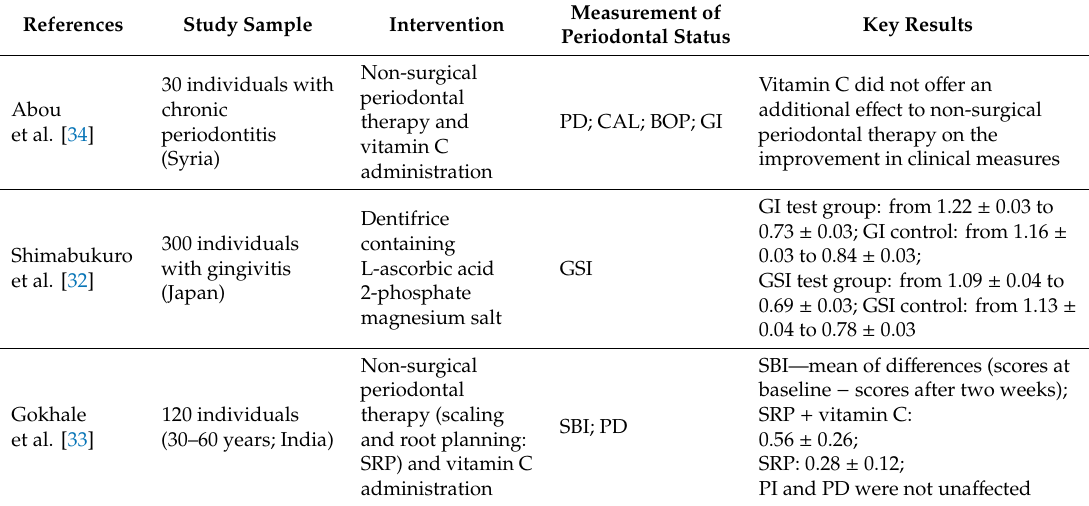
Table 9. Summary of RCT studies in the improvement of periodontal status by vitamin